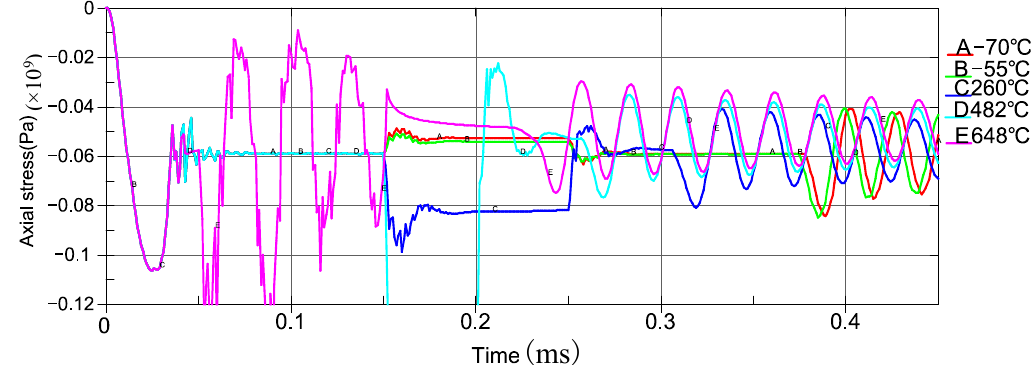
Figure 18. Average axial stress with respect to time under different temperature in Table 4. The details of system responses with optimized coe ffi cients of thermal expansion.